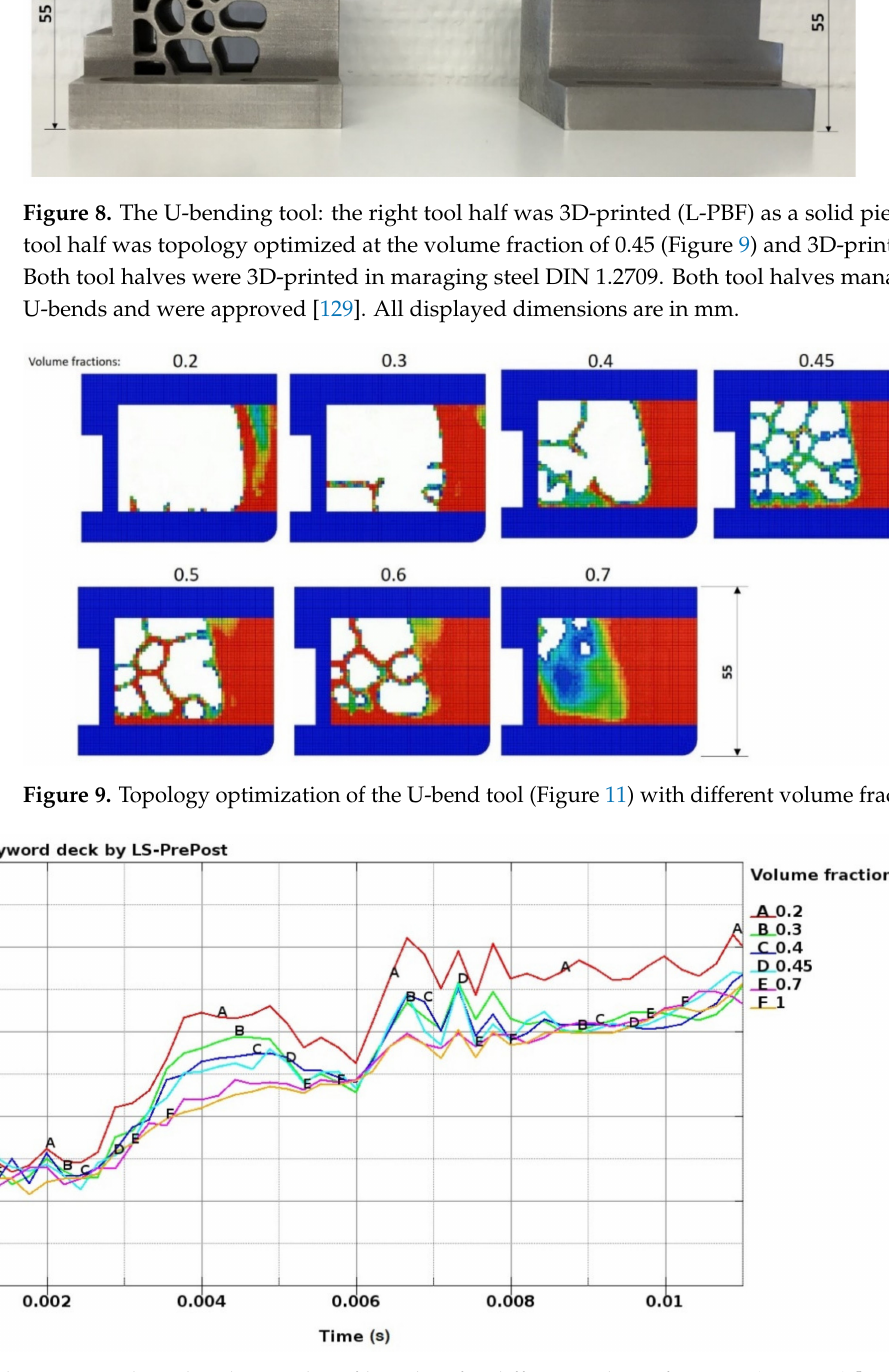
Figure 10. The Z-displacement at the U-bending tool profile radius for different volume fractions (Figure 9)